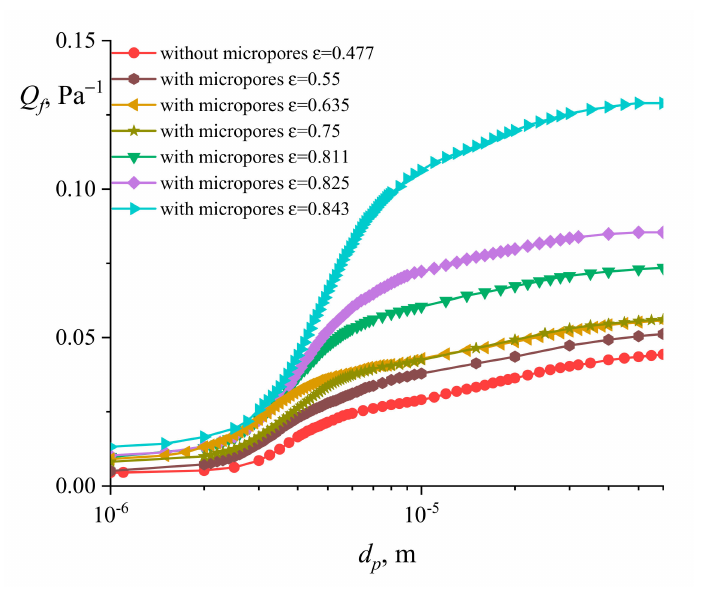
Figure 10. Changes in the quality factor versus the particle diameter for a filter with microporous